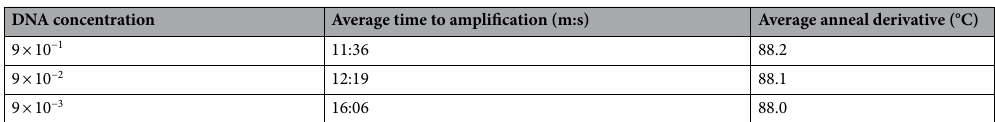
Table 2. The average amplification time and anneal derivative for serial dilutions of Fusarium oxysporum f. sp. ciceris genomic DNA.